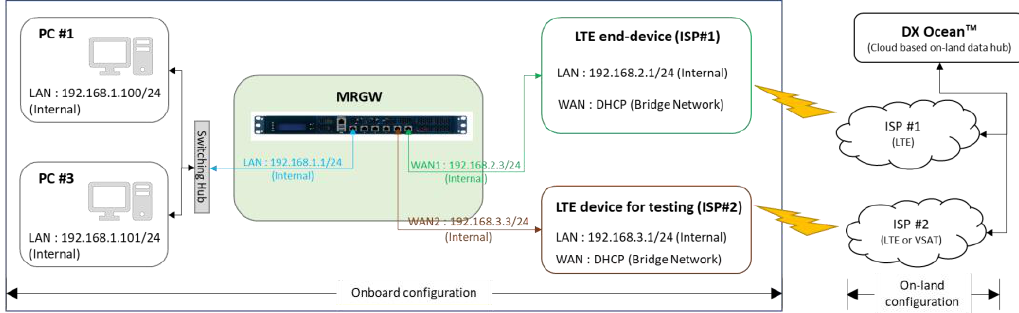
Figure 14. System configuration for test scenario 3 for evaluating the operation of MRGW in inter- working with DX Ocean ™ .